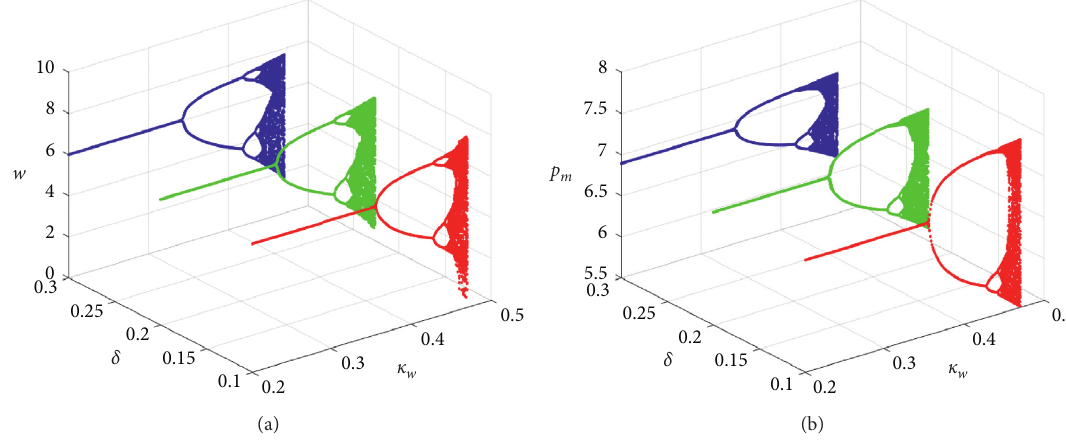
Figure 4: 3D bifurcation diagrams of w in (a) and p